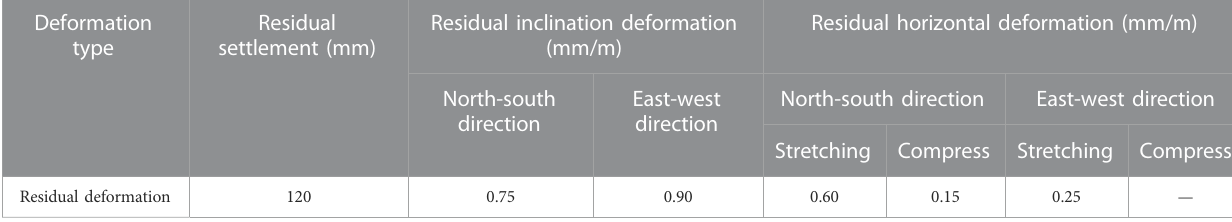
TABLE 4 Surface movement and deformation in the project area.